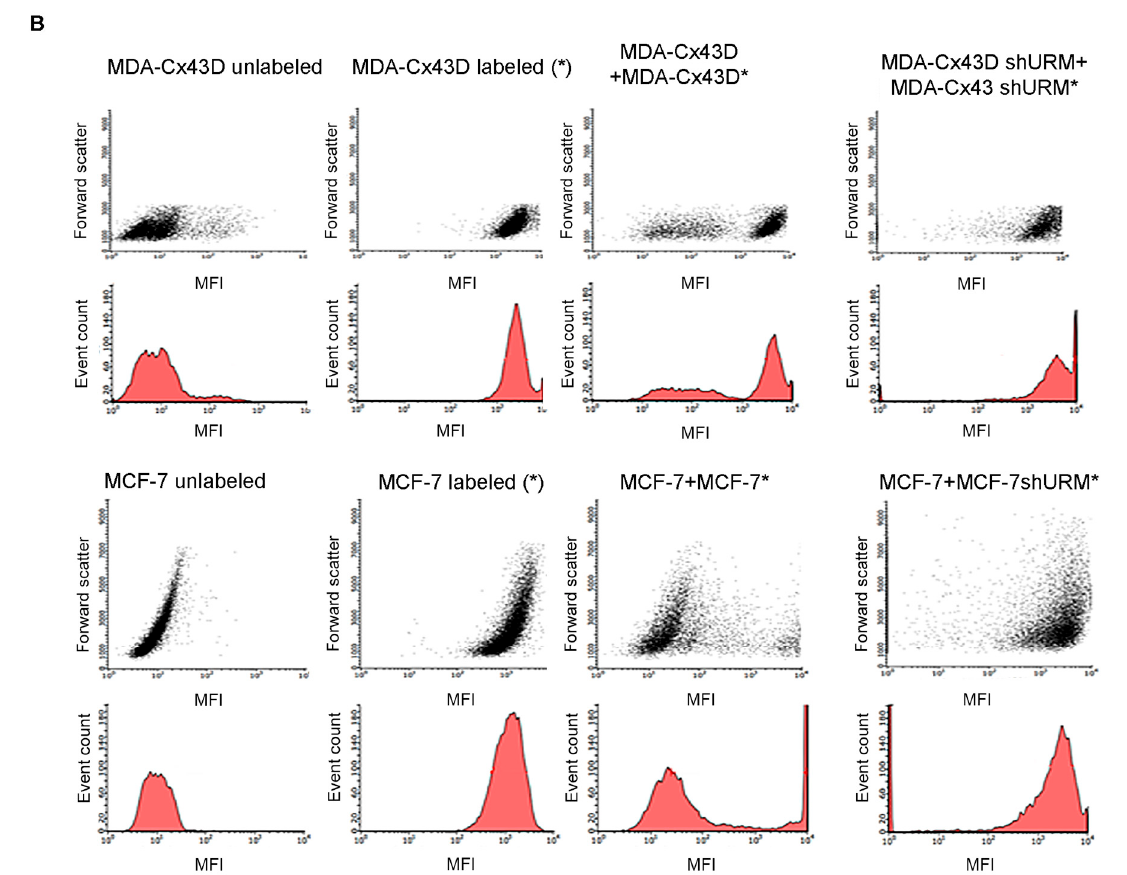
Figure 4. Loss of URM-1 affects the capacity of Cx43 to form functional gap junctions in breast cancer cell lines. ( A ) Cell migration determined by wound healing assay: Upper panel shows optical microscope images presenting scratch areas covered by migrating MDA-MB231, MDA-Cx43D, MDA- Cx43D ShURM, MCF-7, and MCF-7 just after scratching (0 h) and 48 h after scratching. Lower panel shows quantitative evaluation of wound closure (%) expressed as the percentage of the wound area covered by the cells 48 h after scratching. 10 × magnification. ( B ) Flow cytometry analysis of dye transfer assay showing gap junction intercellular communication established between MDA-Cx43D, labeled MDA-Cx43D (MDA-Cx43D*), and MDA-Cx43D ShURM* or MCF-7 and MCF-7 ShURM*. Forward scatter, cell count, and mean fluorescence intensity are represented in the graphs. The depicted result is a representative experiment of three independent